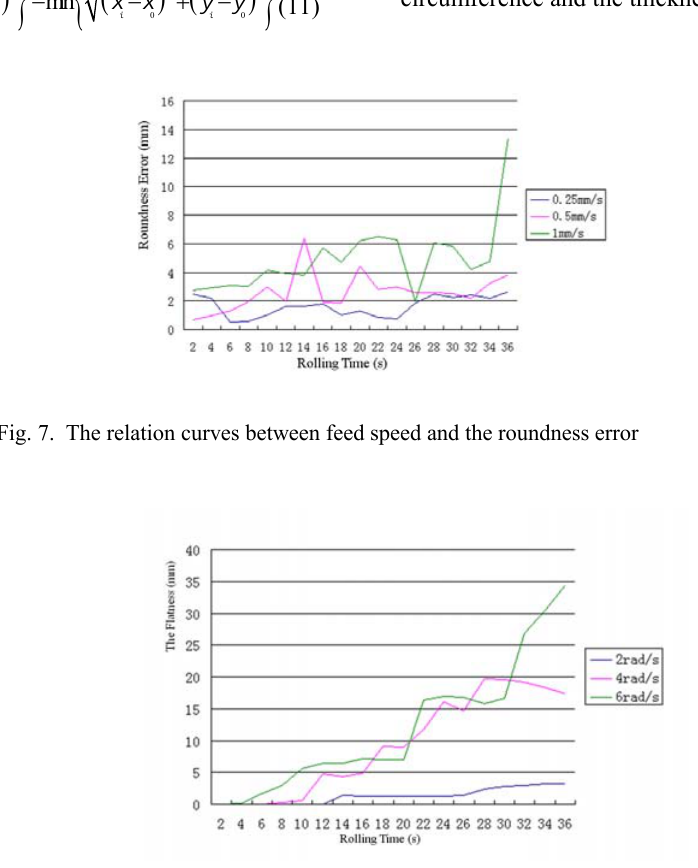
Fig. 8. The relation curves between the feed speed and the end face flatness